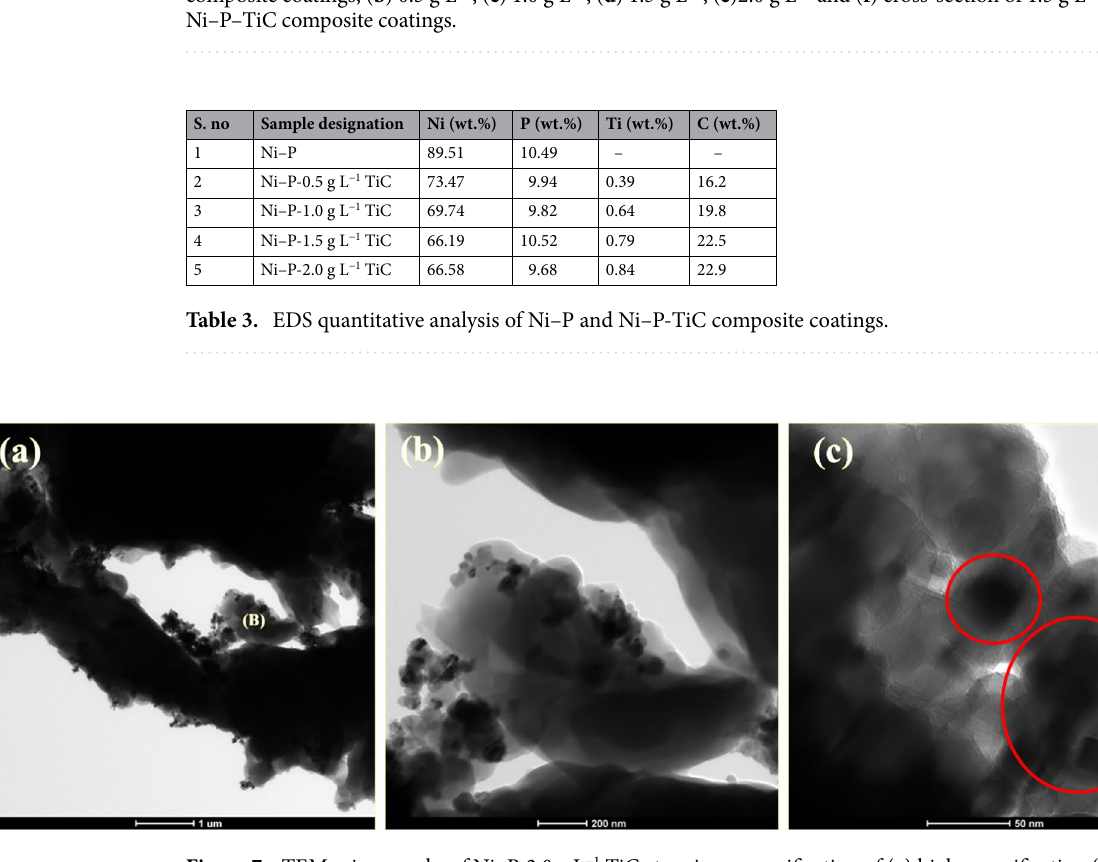
Figure 7. TEM micrographs of Ni–P-2.0 g L −1 TiC at various magnification of ( a ) high magnification ( b ) magnified portion marked (B) in ( a ) and ( c ) showing an interface of the Ni–P matrix and TiC